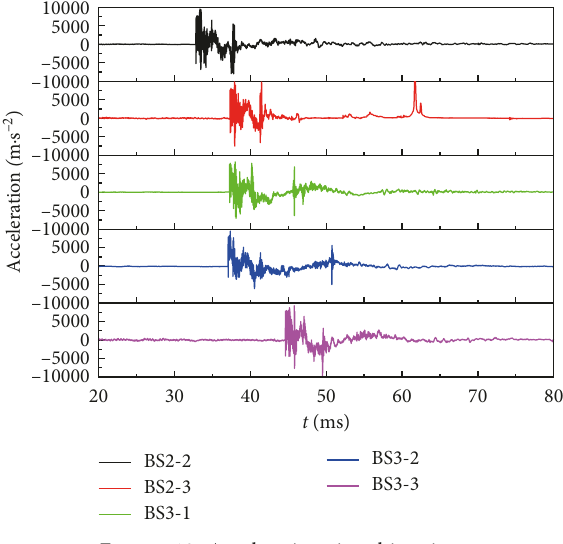
Figure 10: Acceleration-time histories. Table 6: Acceleration-time history summary of